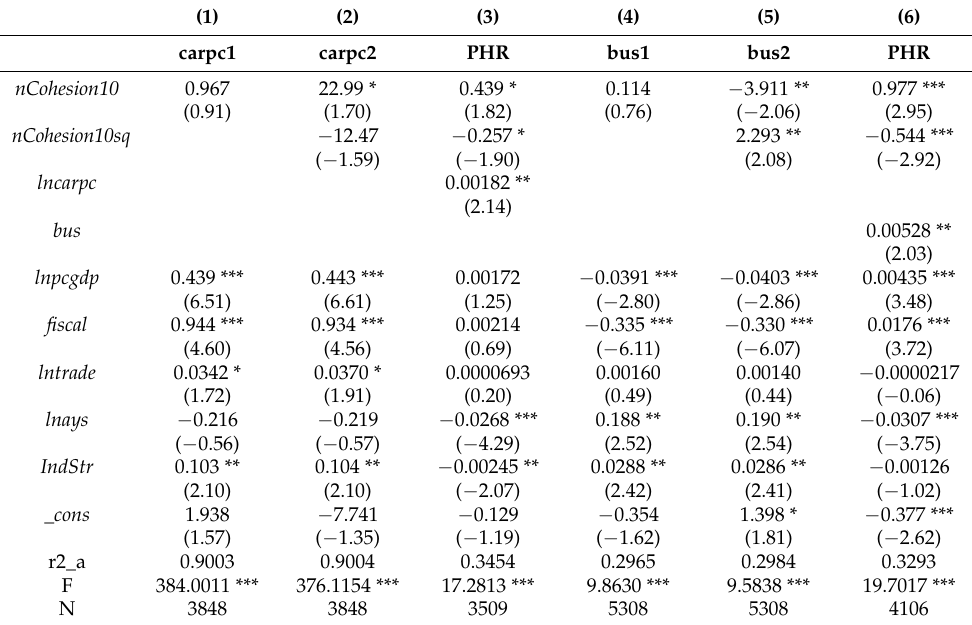
Table 6. Mechanism tests: impact of city shape on